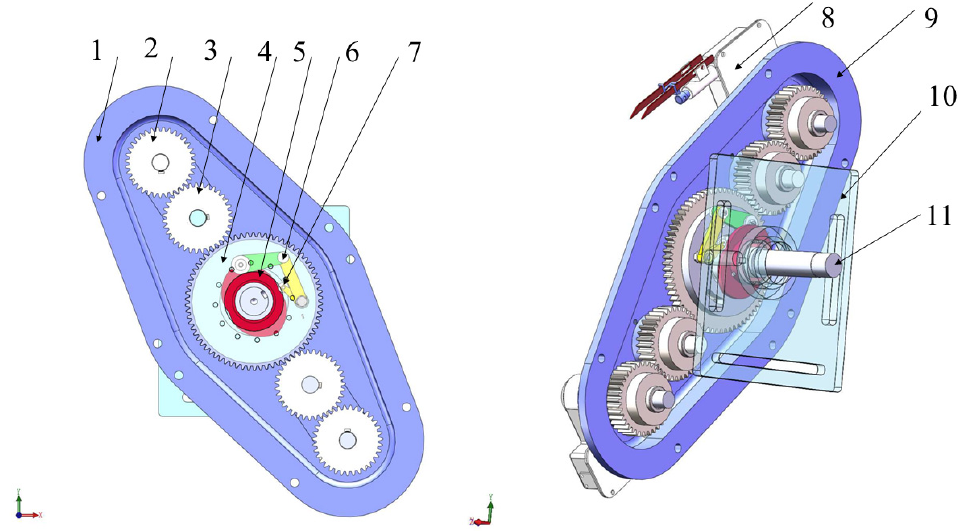
Figure 2. Cam-linkage planetary gear system seedling picking mechanism: 1. Left housing; 2. Planetary gear; 3. Intermediate gear; 4. Sun gear; 5. Cam; 6. Linkage mechanism; 7. Roller; 8. Seedling picking arm; 9. Right housing; 10. Rack mounting plate; and 11. Input shaft.